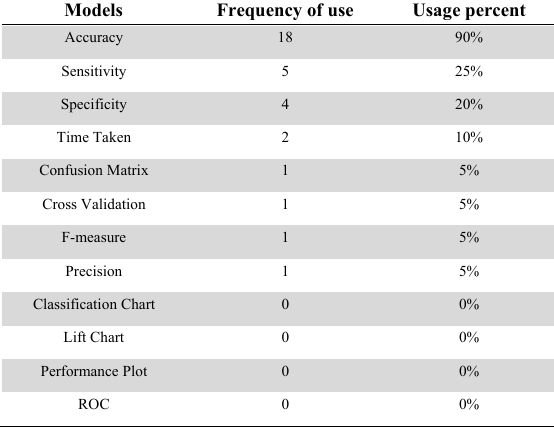
Comparison of the evaluation methods